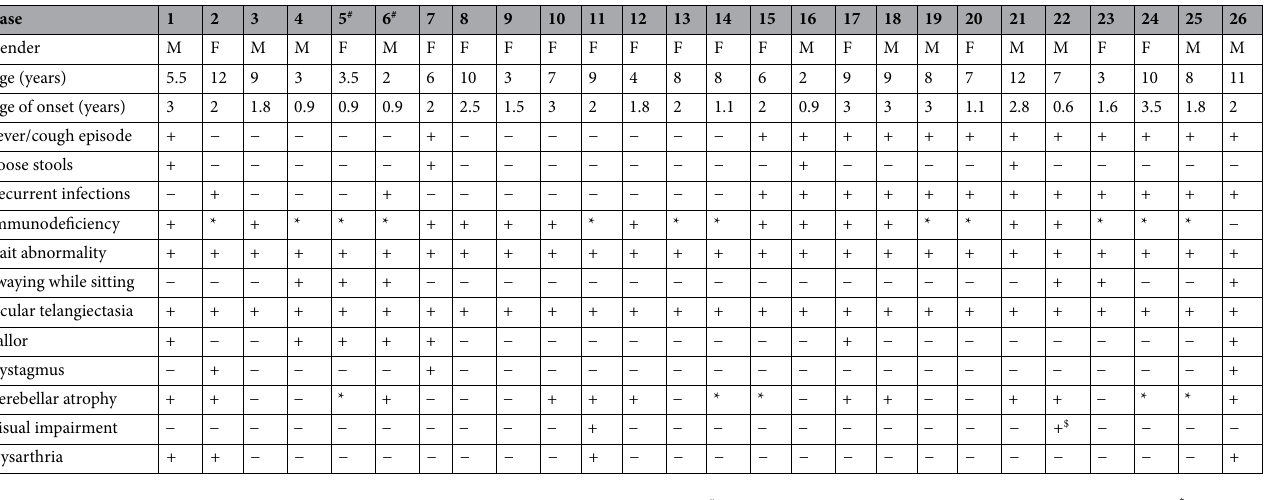
Table 2. Clinical details of 26 patients with A-T. # Siblings (in adjacent columns). *Data not available. $ Retinitis